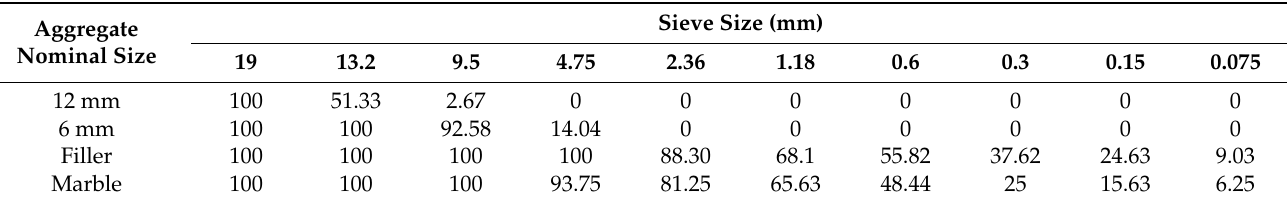
Table 3. Aggregate Gradation